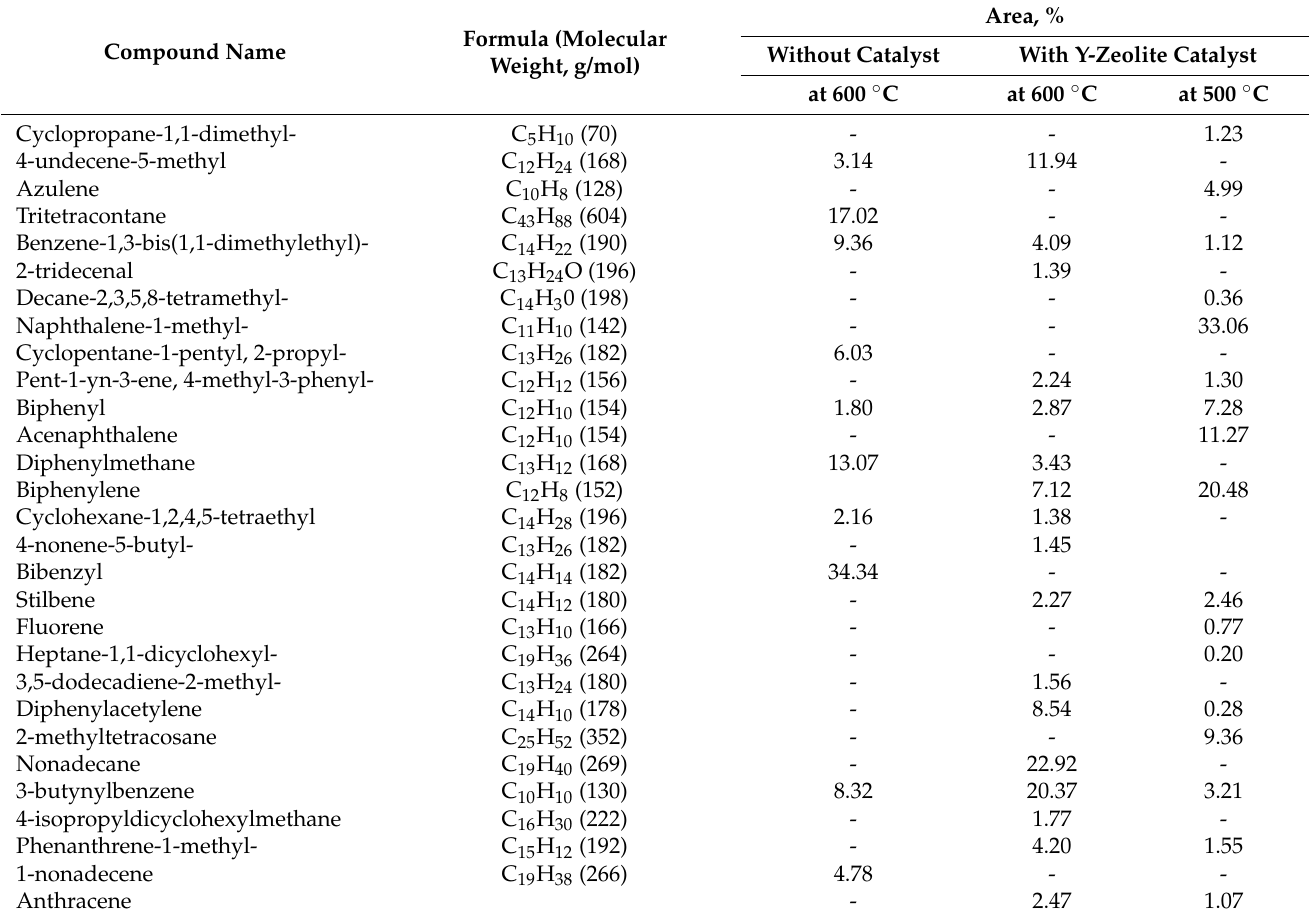
Table 2. Analysis of landfill liner by Py-GC/MS with and without Y-zeolite